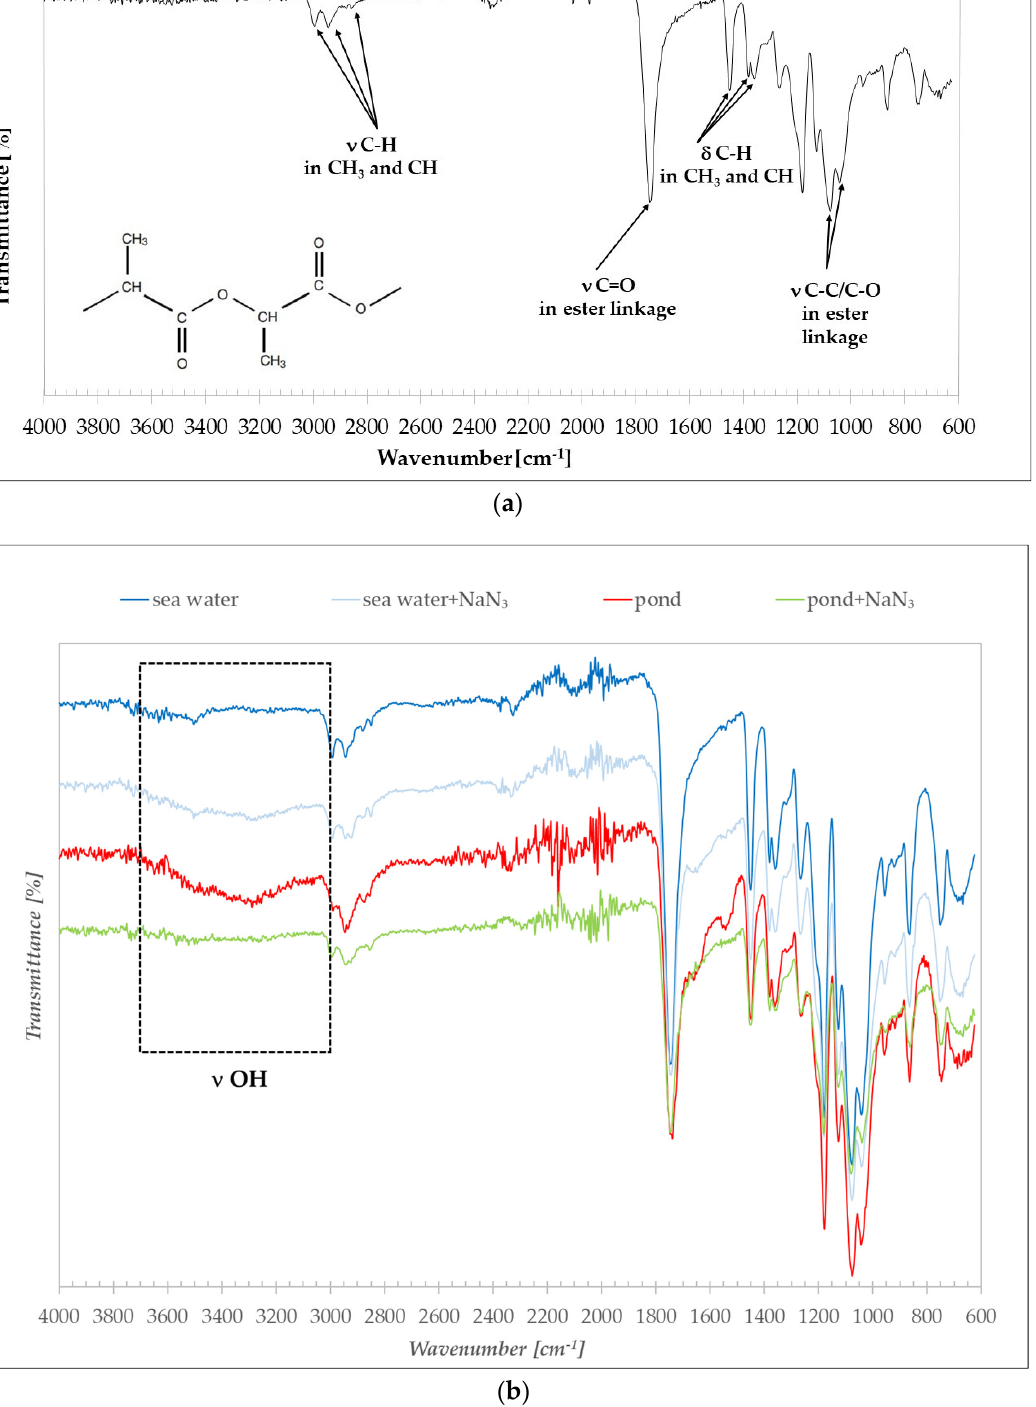
Figure 3. ATR-FTIR spectra of the PLA sample in the wavenumber of 600–4000 cm − 1 : ( a ) before degradation; ( b ) after 12 months of degradation in aqueous environments. Source: Own research.